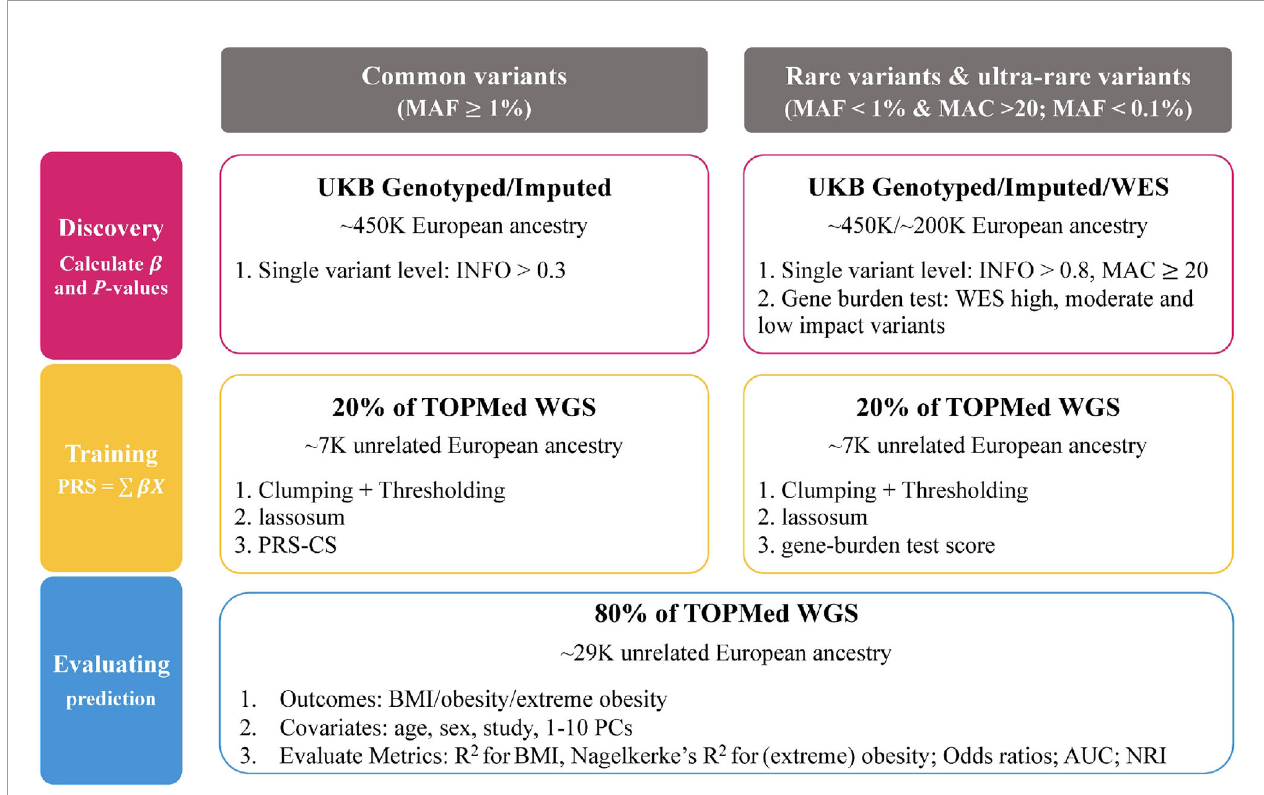
FIGURE 1 | Overview of the study